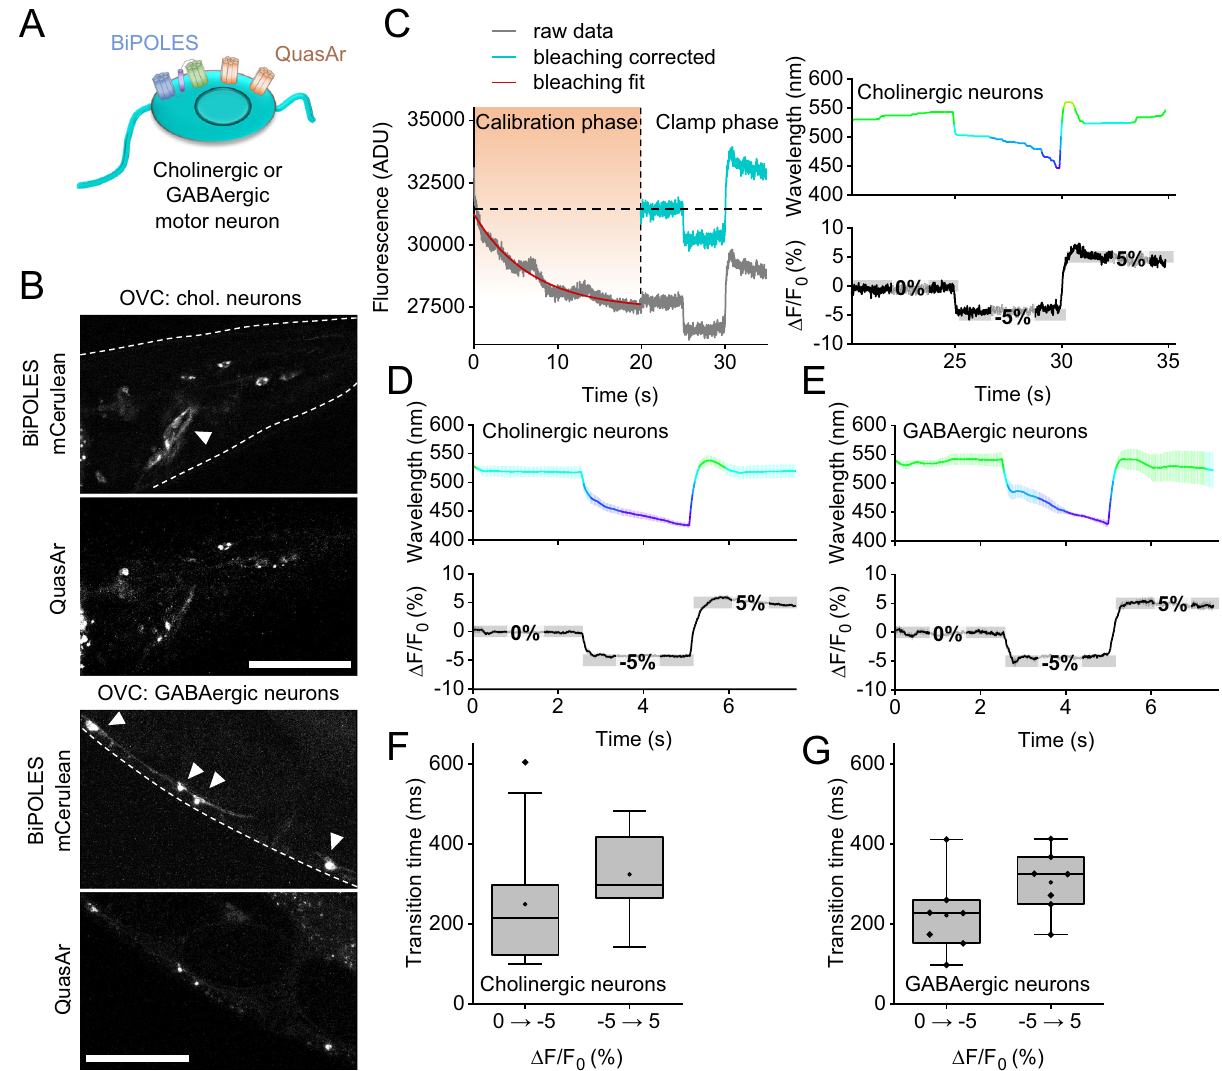
Fig.4|Bi-directionalclampingofvoltage-dependent fl uorescencein C.elegans neurons. A OVC in cholinergic or GABAergic neurons. B Confocal fl uorescence z-projections of BiPOLES (mCerulean) and QuasAr2 expression. Arrowheads: Neu- ronalcellbodies.Scalebars:50 µ m.Representativeimage(from n =11(cholinergic) or 16 (GABAergic neurons)). C OVC protocol (holding values 0, − 5, 5% Δ F / F 0 )